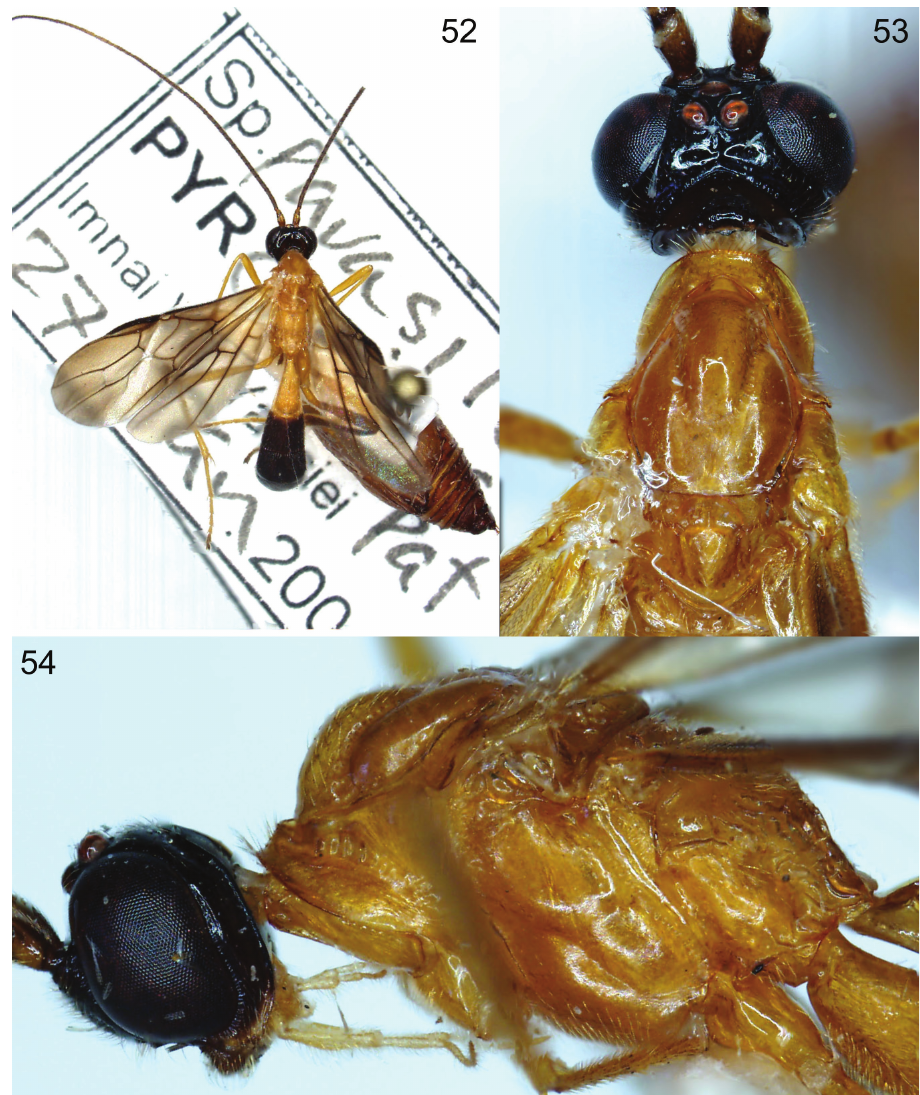
Figures 52–54. Colastomion maclayi sp. n. holotype, Cell^D® light photomicrographs. 52 Habitus, dorsal view 53 head and anterior mesosoma, dorsal view 54 head and mesosoma, lateral view. : 1.9. Face largely finely transversely striate. Shortest distance between posterior ocelli: transverse diameter of posterior ocellus: shortest distance between posterior ocellus and eye = 1.0 : 3.0 : 1.1. Occipital carina well developed, complete mediodorsally. Mesosoma . Notauli weakly impressed anteriorly, dorsally represented by converging lines of discrete pits. Mesoscutum smooth where notauli converge. Propodeum with complete midlongitudinal